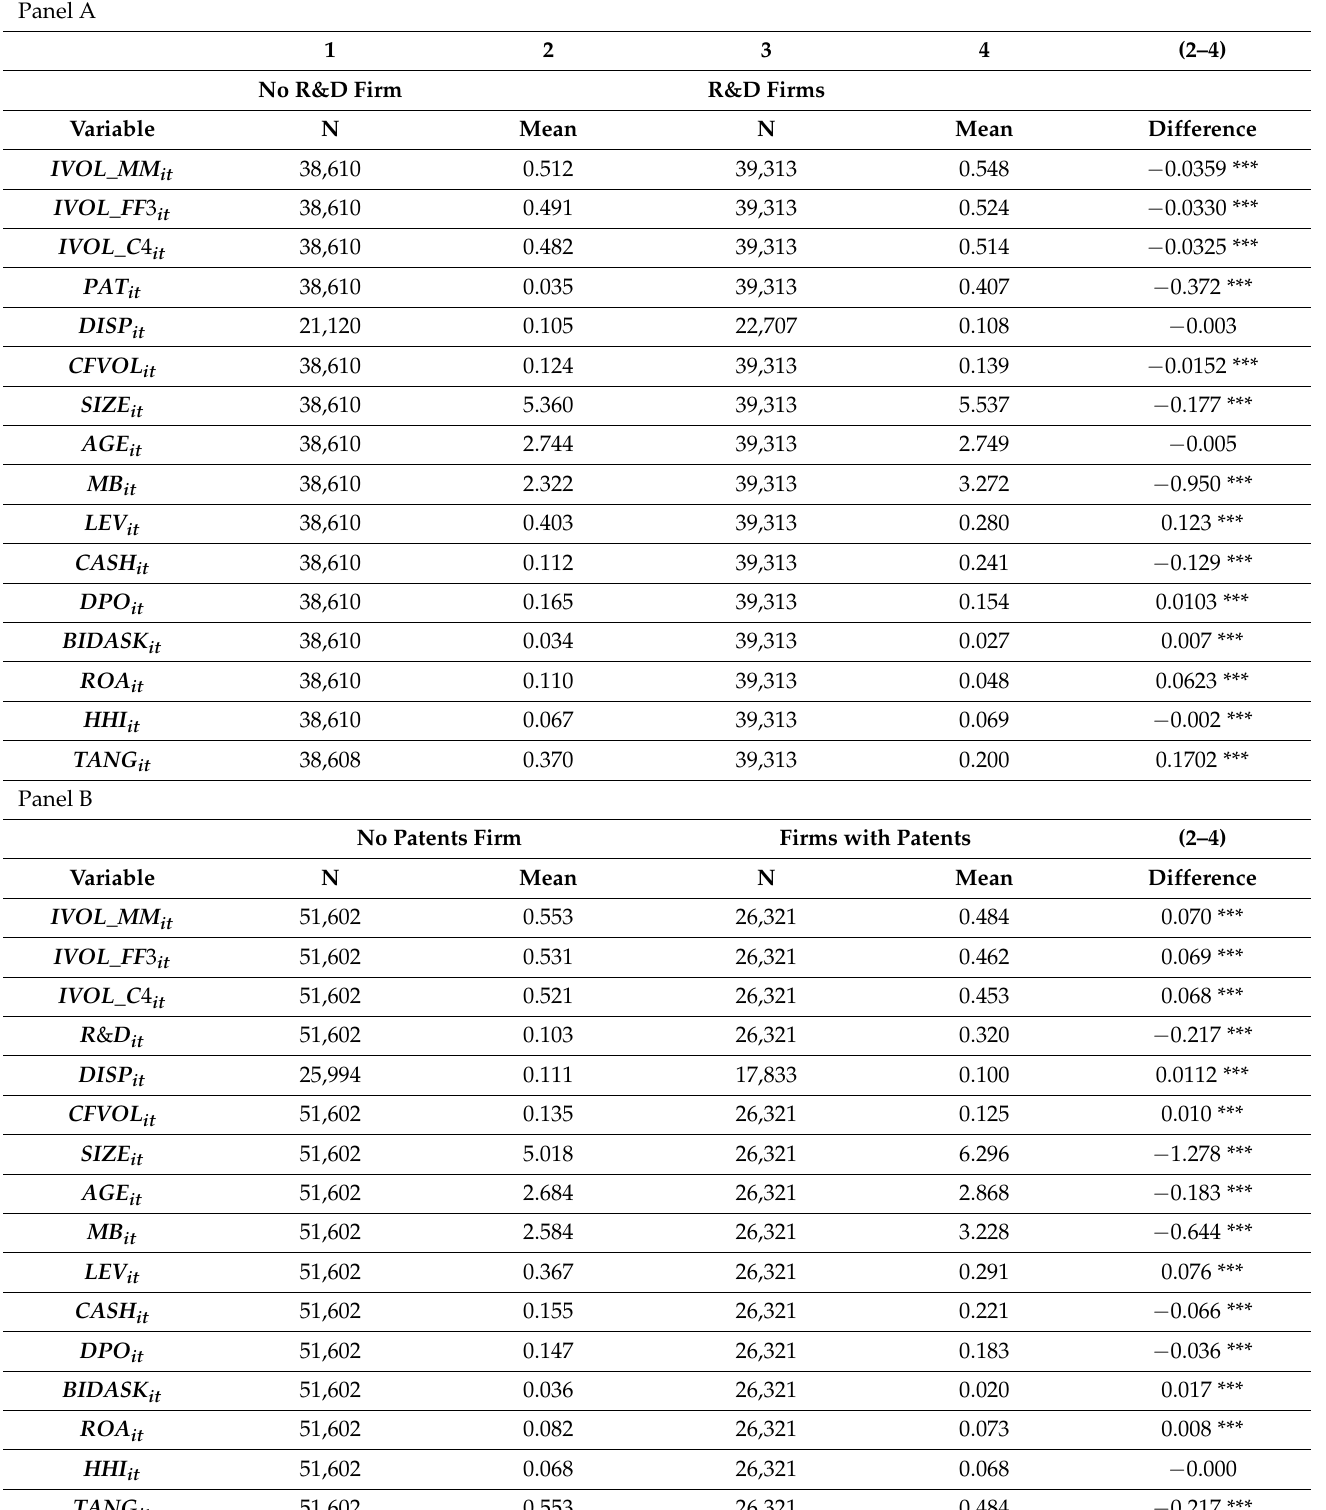
Table 3. Comparison of means test. Panel A shows the comparison of means t -test after classifying the firms in our sample as No-R&D firms or R&D firms. Panel B shows the comparison of means t -test after classifying the firms in our sample into firms with no patents and firms with patents. The t -statistic is adjusted for unequal variance. The sample period is from 1982 to 2015. ***, **, and * denote significant two-tailed p -values ≤ 1%, 5%, or 10%,